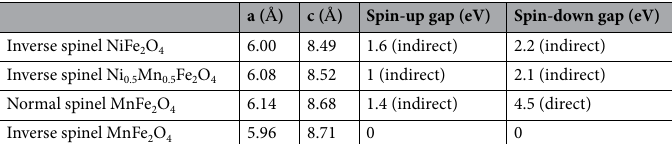
Table 4. Lattice constants, spin-up gap, and spin-down gap calculated by